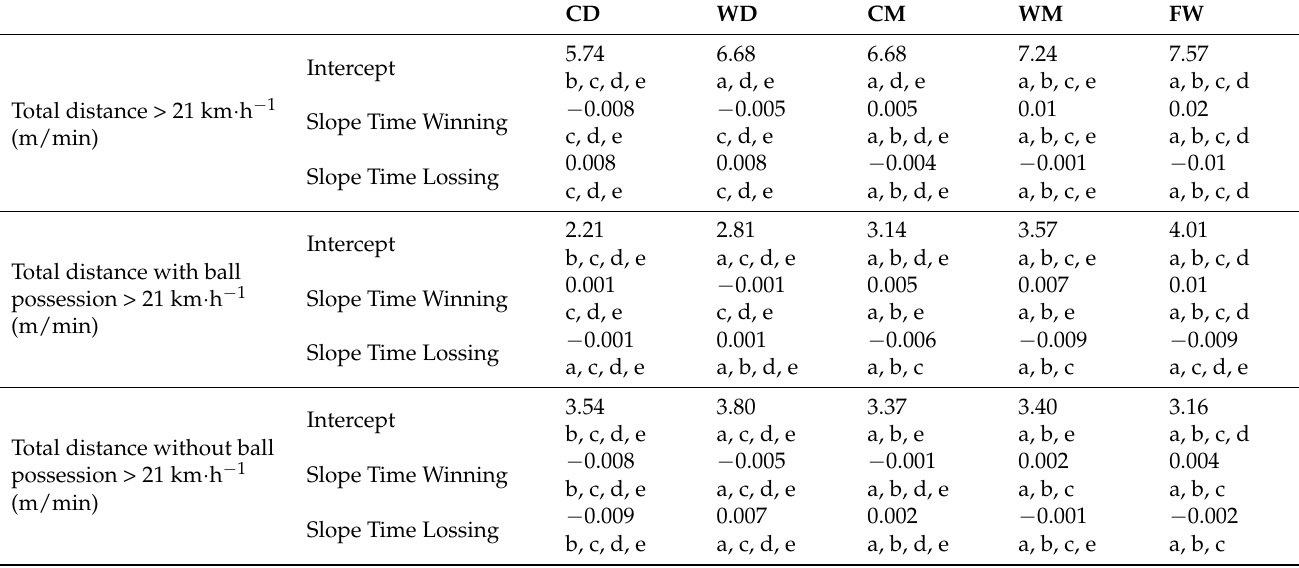
Table 2. Differences by ball possession of position-specific total distance covered at more than 21 km · h − 1 according to the scoreline